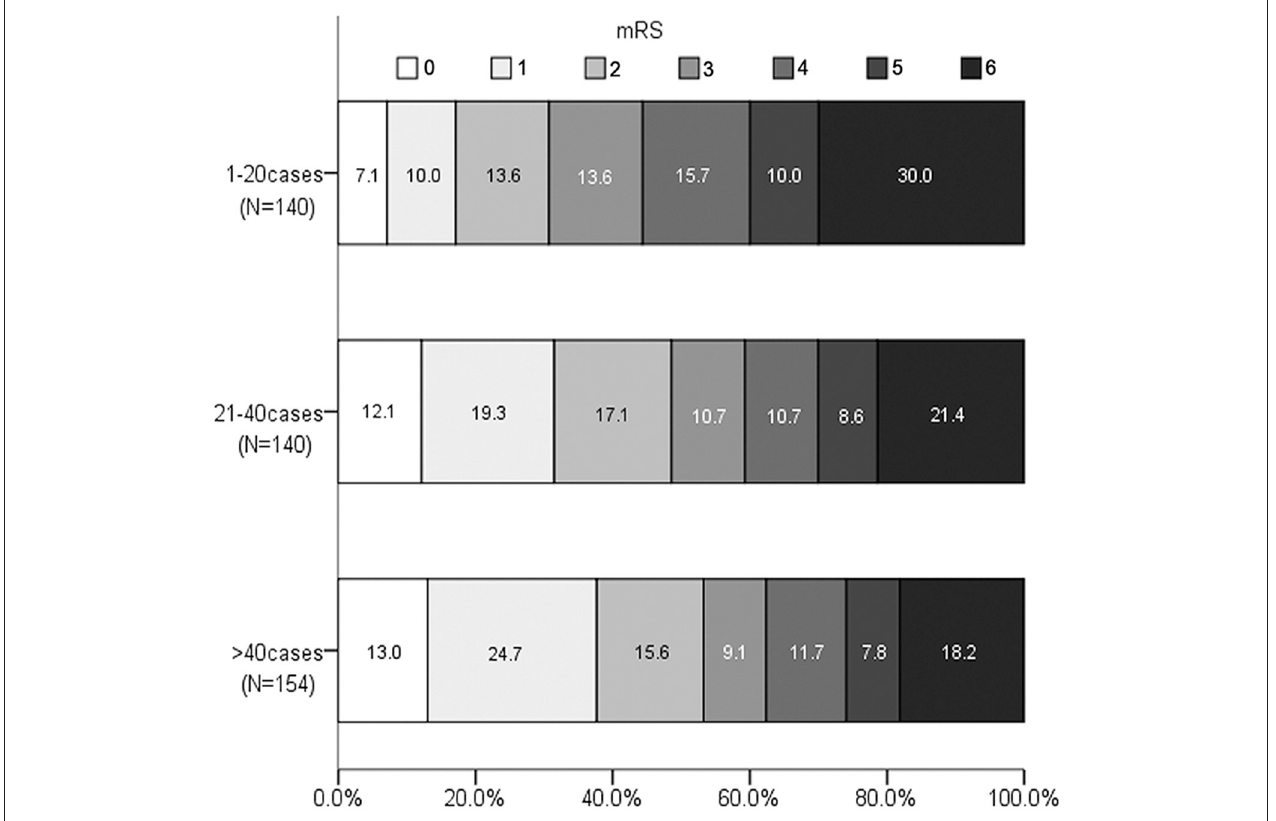
FIGURE 1 | Distribution of Modified Rankin Scale score at 90 days according to experience categories.